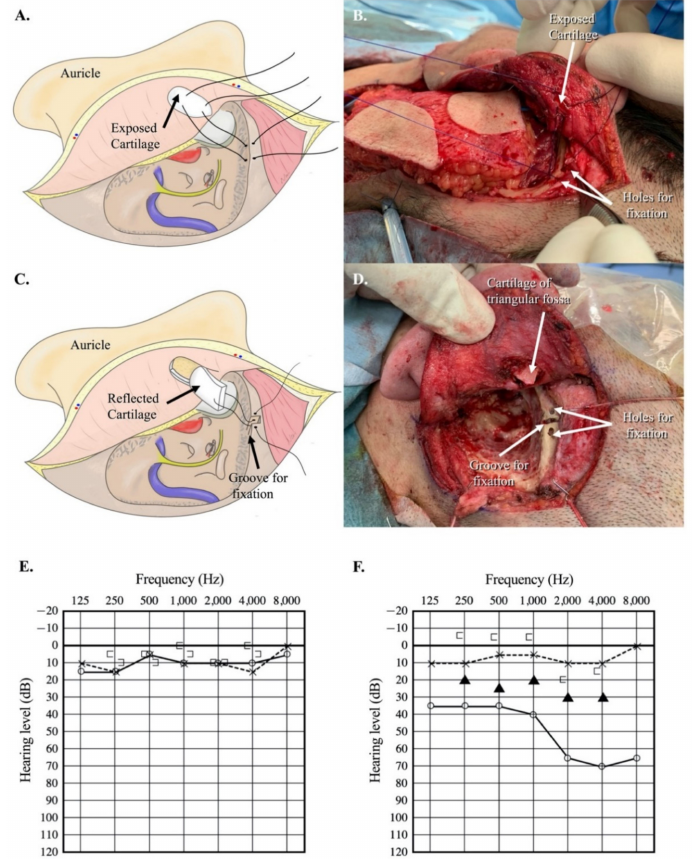
Figure 4. Bone–cartilage anchoring technique (BCA). ( A ) Auricular cartilage was anchored to the temporal bone with a 3-0 PDS suture (Type 1). ( B ) Surgical view of the Type 1 bone–cartilage anchoring technique (Case 13). ( C ) The auricular cartilage was inserted into the created groove of the temporal bone and fixed with a 3-0 PDS suture (Type 2). ( D ) Surgical view of the type 2 bone–cartilage anchoring technique (Case 12). ( E ) Preoperative pure-tone audiometry (Case 10). ( F ) Postoperative pure-tone audiometry of case 10 after the bone–cartilage anchoring technique. The black triangle shows the hearing level with a cartilage conduction hearing aid at a sound field with adequate masking on the contralateral